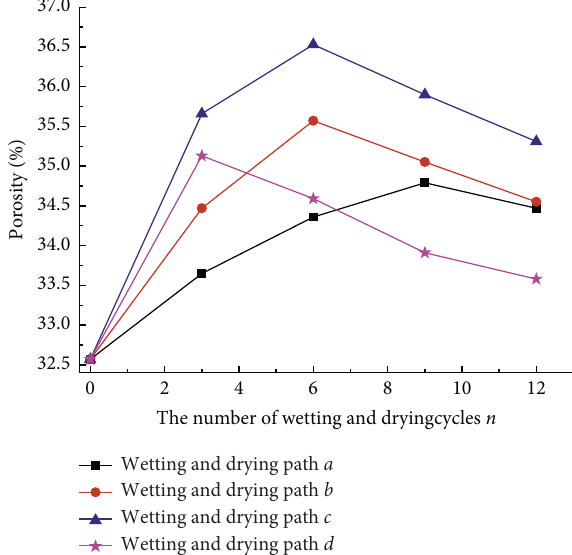
Figure 13: Changes of porosity of compacted loess under W - D